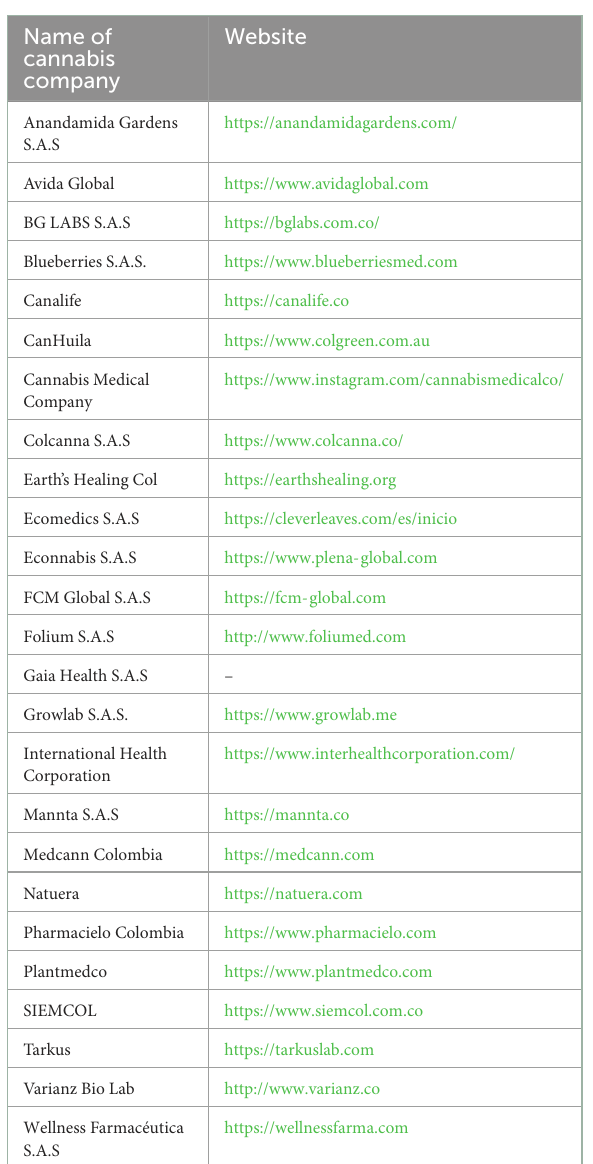
TABLE 3 Colombian cannabis companies associated to ASOCOLCANNA